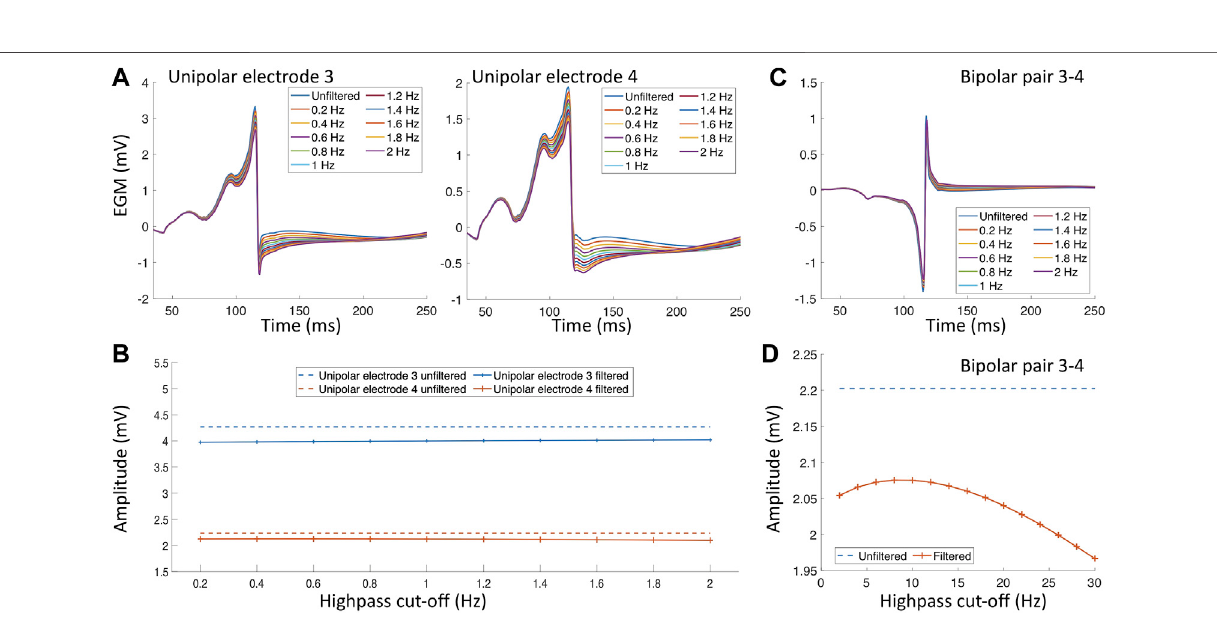
the presence of fi brotic tissue, uEGMs and biEGMs have a different frequency spectrum and are affected in a different manner. Figure 5D shows that there is no optimal cut-off frequency as previously reported by Starreveld et al. (2020). The fi ltered biEGM amplitude (orange line) drops due to the highpass cut-off but does not intersect the un fi ltered amplitude (blue dashed line) as is the case for healthy myocardium ( Figure 3D ).